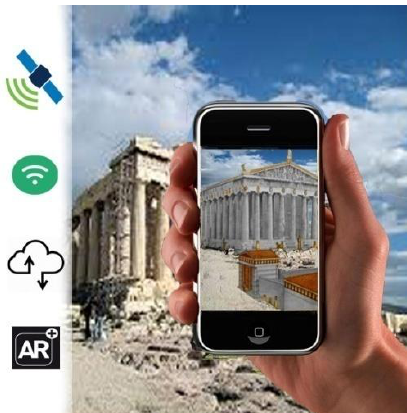
Figure 1. A hypothetical scenario, the visitor of the monument opens his mobile camera and aims at a point of interest.